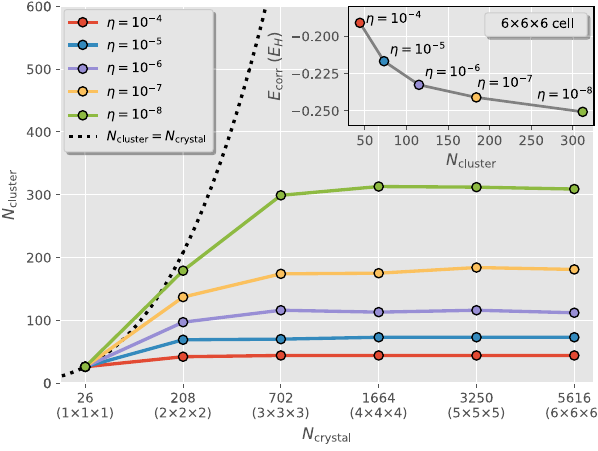
FIG. 2. Number of cluster orbitals N for an embedded cluster carbon atom in a diamond simulation cell as a function of the number of crystal orbitals N for different supercell sizes and crystal bath natural orbital thresholds η . The black dotted line marks the y ¼ x diagonal denoting the total number of degrees of freedom , in the system. Note that the x axis is linear with respect to N 1 = 3 crystal which is why the diagonal has the shape of a cubic function. Inset: convergence of the embedded CCSD correlation energy as a function of the cluster size for the 6 × 6 × 6 supercell. The calculations are performed with GTH pseudopotentials [47,48] and the GTH DZVP basis set